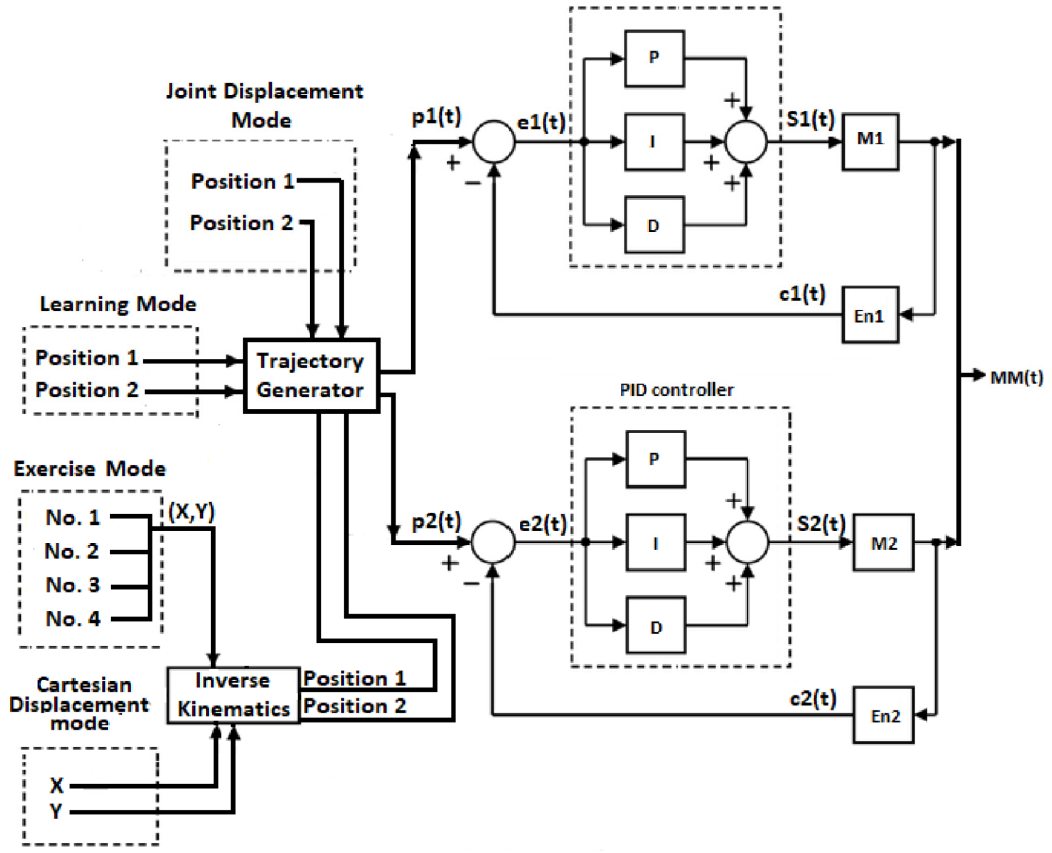
Appl. Sci. 2020 , 10 , x FOR PEER REVIEW Figure 9. The designed control strategy scheme. Figure 9. The designed control strategy scheme.